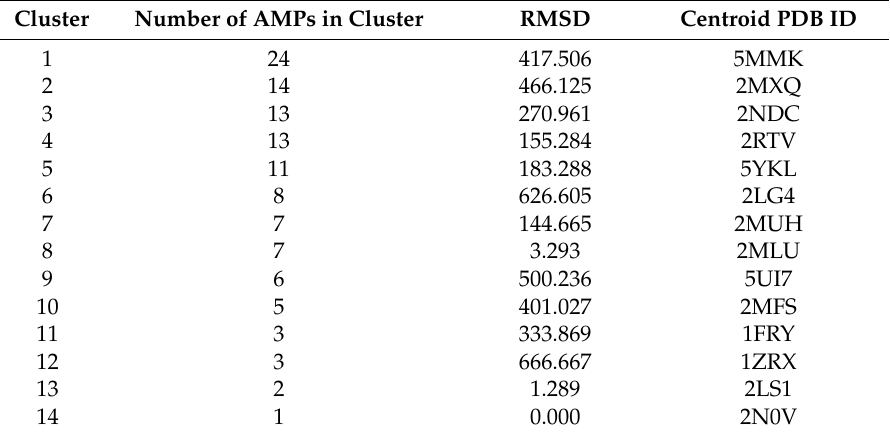
Table 3. Clusters obtained from hierarchical clustering with threshold set at 700.